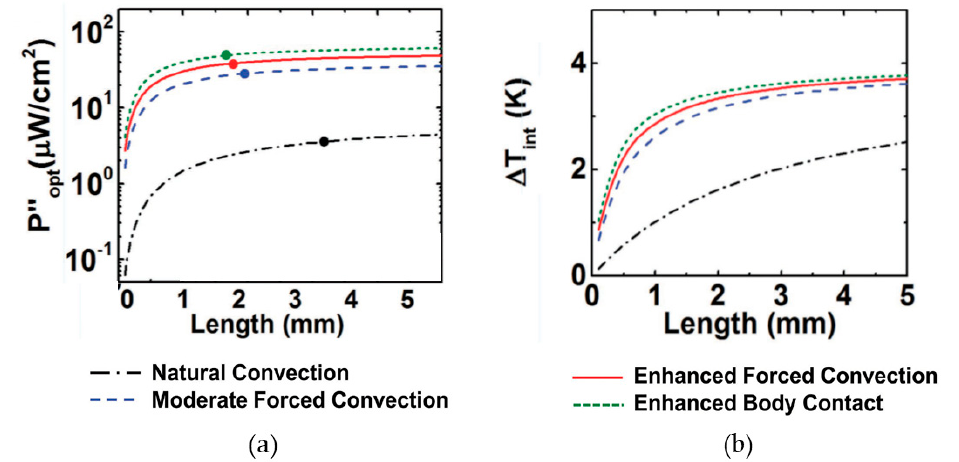
Figure 9. ( a ) Power output comparison of di ff erent cooling methods for di ff erent leg lengths; ( b ) temperature di ff erence for di ff erent lengths [63].